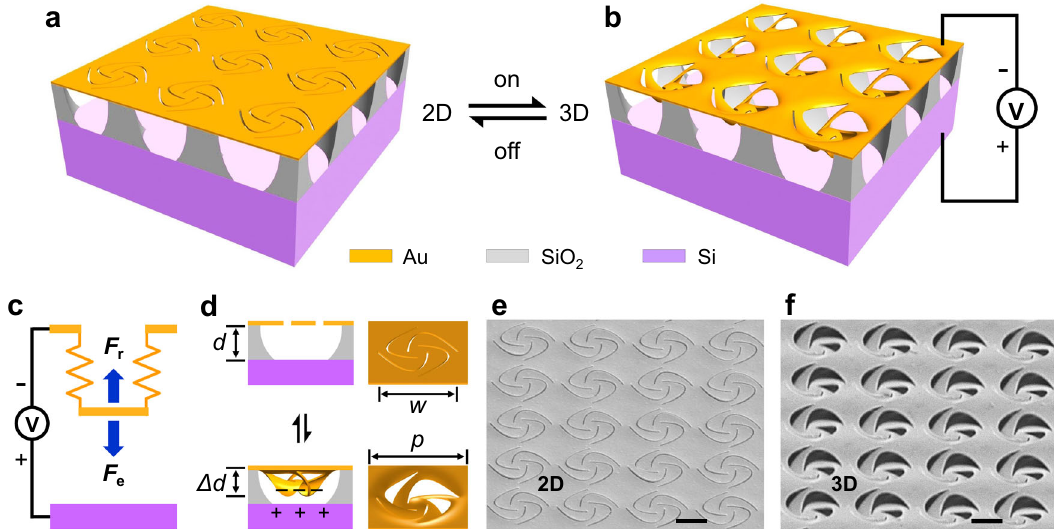
Fig. 1 Scheme for recon fi gurable nano-kirigami. a , b Schematic of a a 2D pinwheel array and b its downward 3D state under attractive electrostatic forces when the voltage is on. Each gold pinwheel is locally suspended by four SiO 2 supporters with thickness of d . c A simpli fi ed electromechanical model of the recon fi gurable nano-kirigami, in which the displacement of the suspended nanostructure is controlled by the downward electrostatic force ( F e ) and upward mechanical restoring force ( F r ). d Front-view and side-view plots of (top) 2D and (bottom) calculated 3D deformed pinwheel in the gold layer. e , f Side-view SEM images of as-fabricated 2D pinwheels and the downward deformed 3D pinwheels after applying DC voltage of V = 65 V. Structural parameters: gold thickness: t = 60 nm; pinwheel width: w = 2 µ m; lattice periodicity: p = 2.25 µ m; d = 500 nm. Scale bars: 1 µ